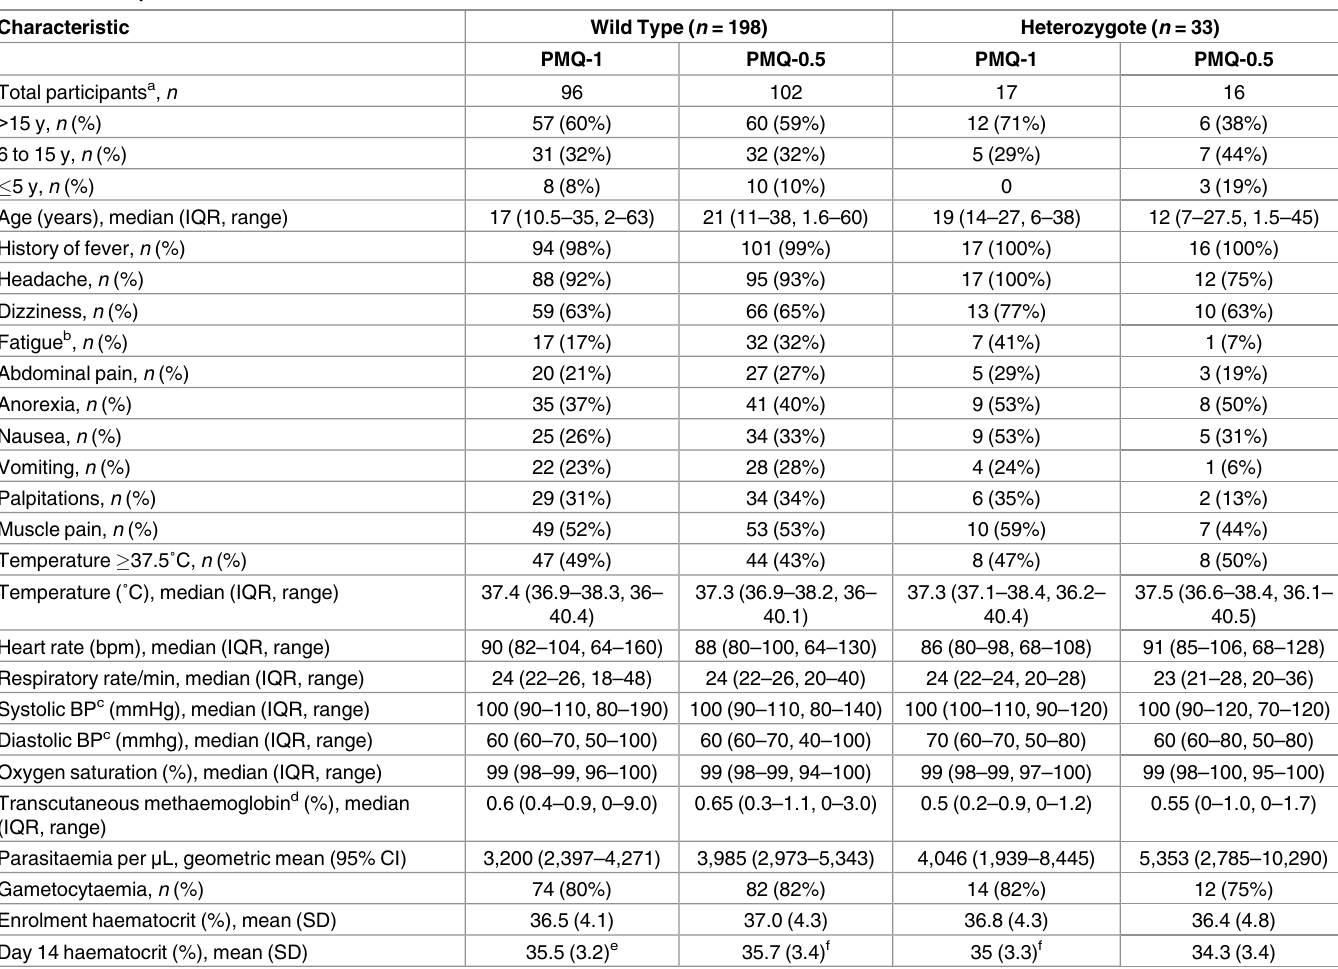
Table 1. Participant